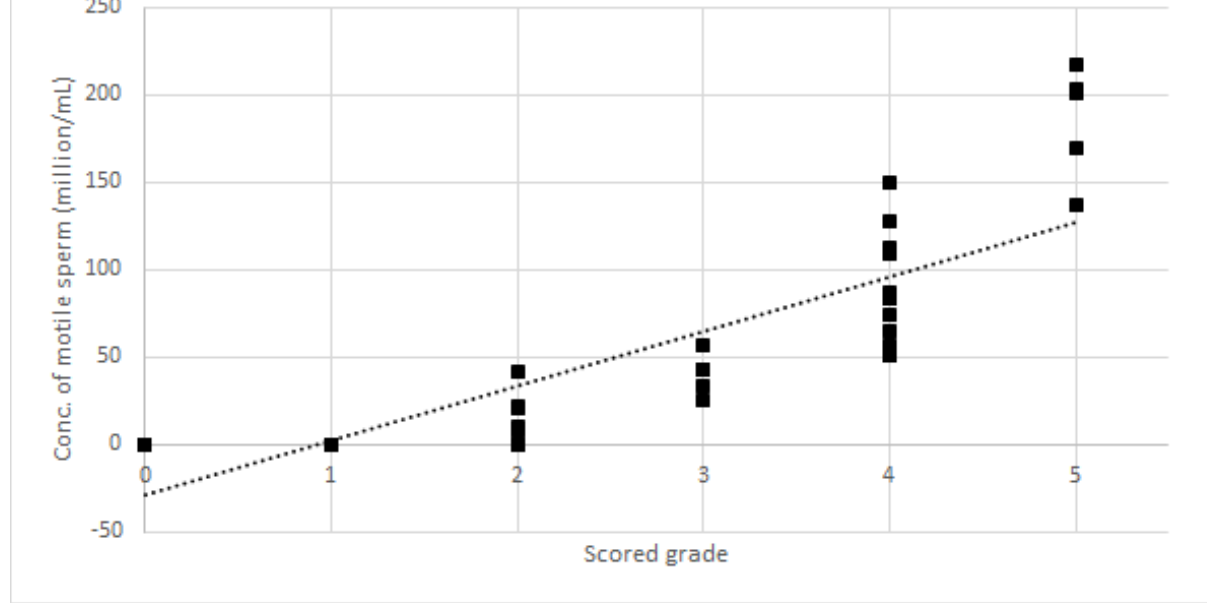
Figure 4. Relationships between Bemaner concentration of motile sperm and scored grades.